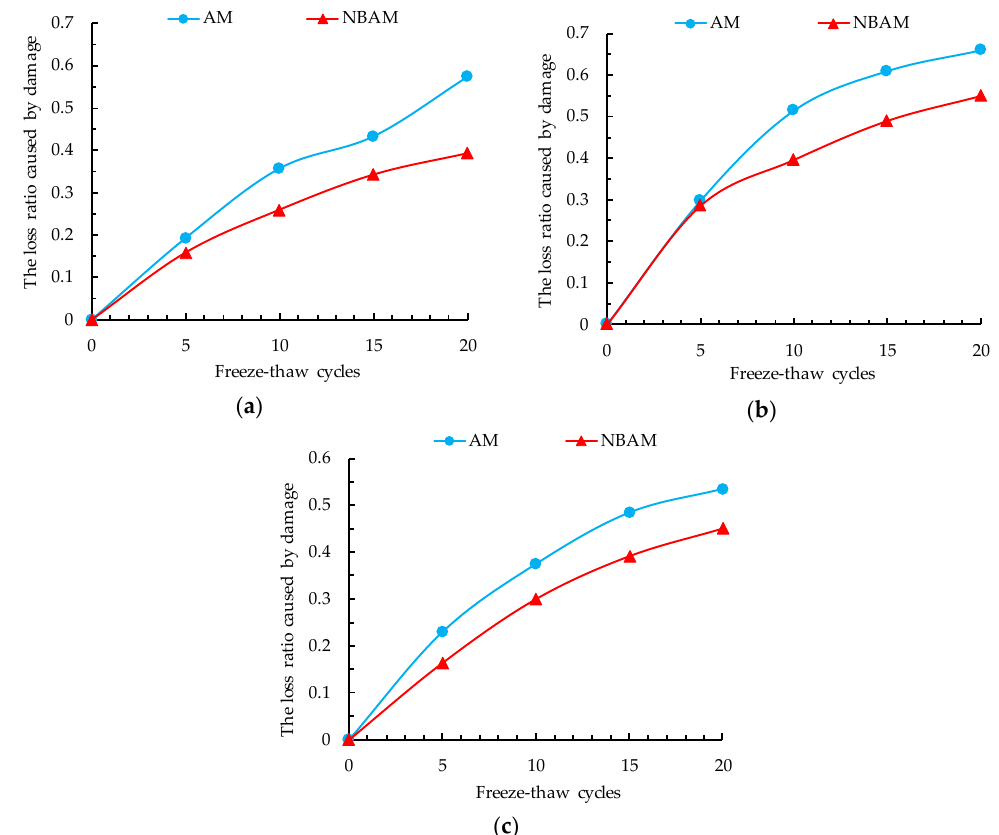
Figure 13. Prediction curves of loss ratio caused by damage: ( a ) loss ratio caused by damage of stability prediction curve; ( b ) loss ratio caused by damage of splitting strength prediction curve; ( c ) loss ratio caused by damage of stiffness modulus prediction curve.